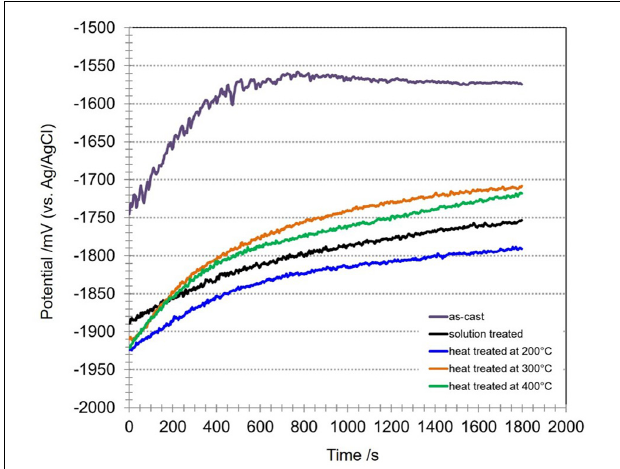
removed when the hydrogen has replaced the total volume of 400 ml water out the column. For the weight loss evaluations, the weight of the specimens before and after the corrosion test